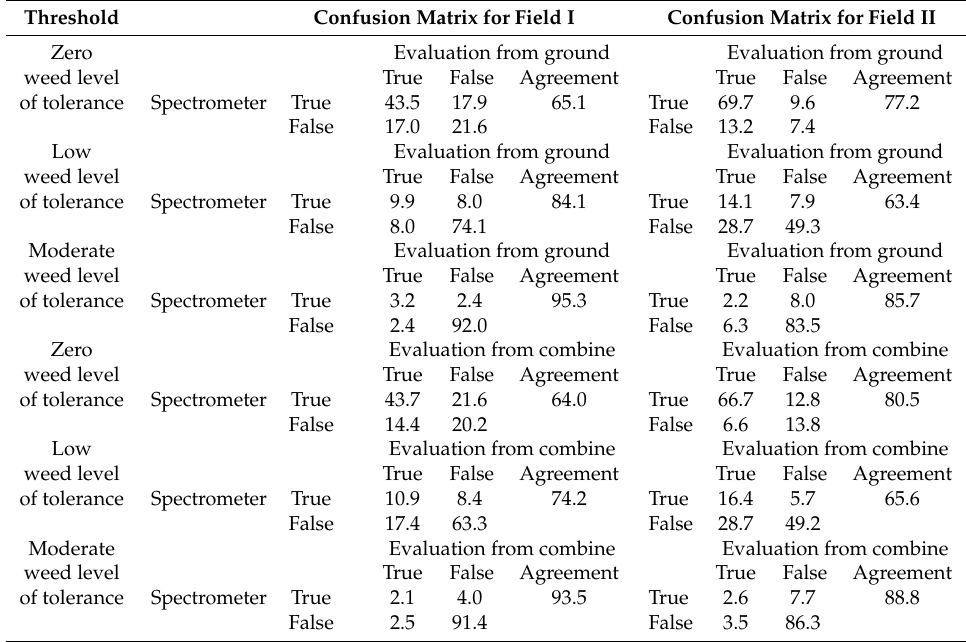
Table 2. Confusion matrix of the weed map from the spectrometer with each of the two reference maps for three different thresholds and for Field I and Field